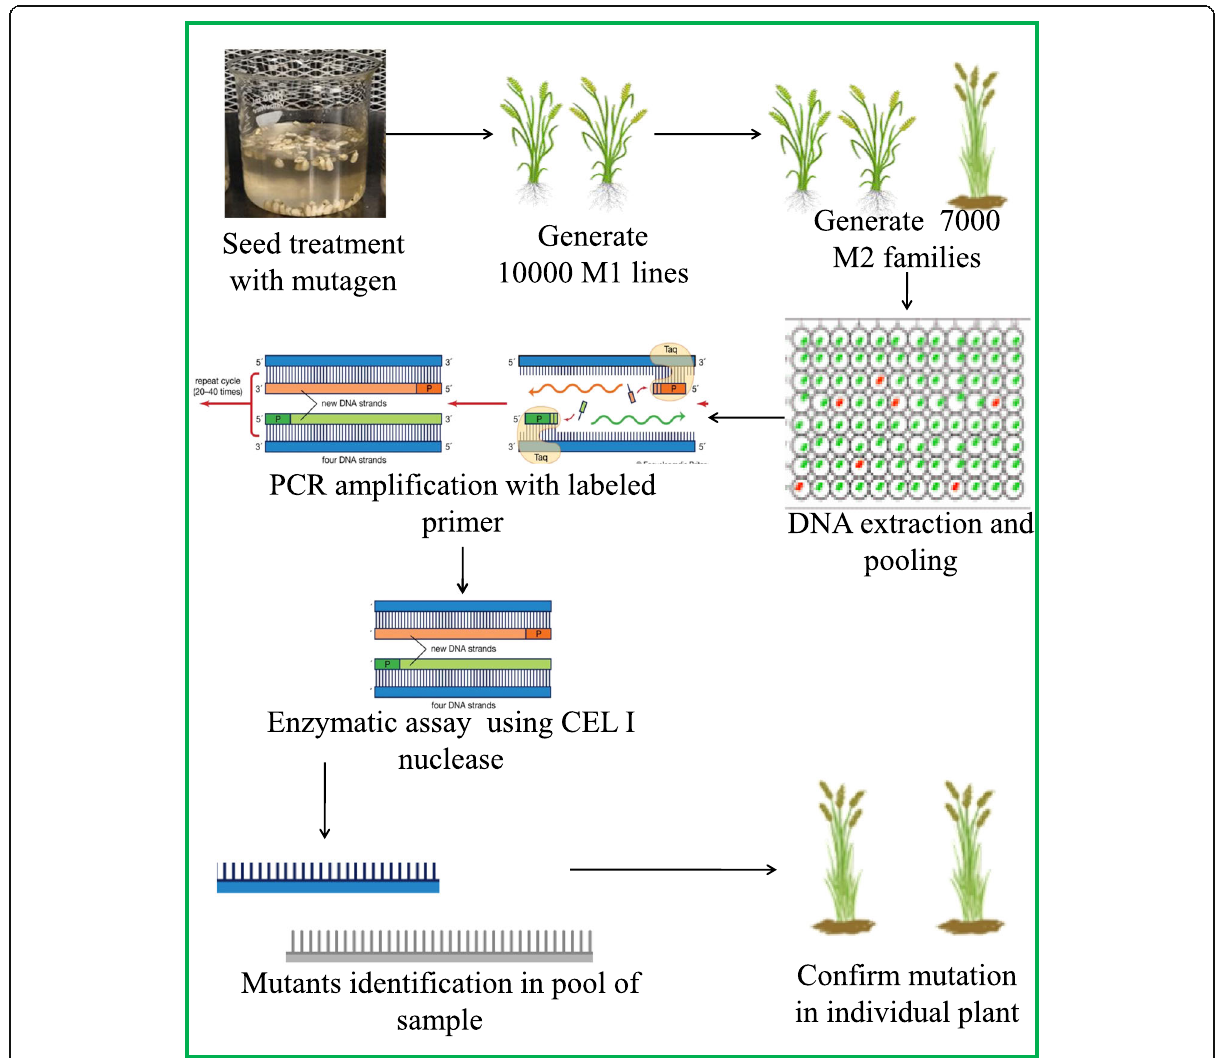
Fig. 3 A schematic representation of traditional TILLING pathways and workflow of TILLING by